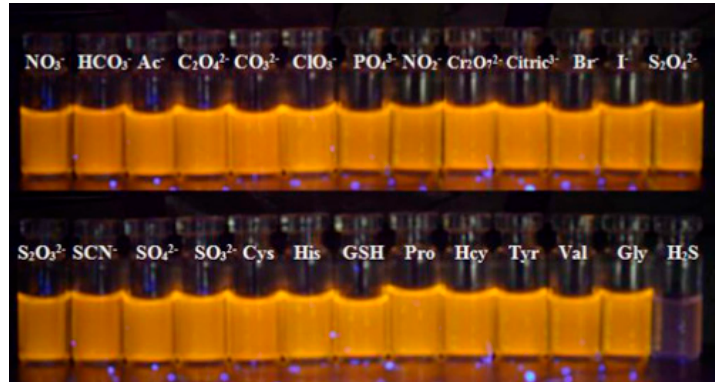
Figure 5. Photographs of acetylcysteine-stabilized gold NCs (ACC@Au NCs) with different analyte solutions viewed under UV light at 365 nm (Copyright Ref [66], ELSEVIER publications).